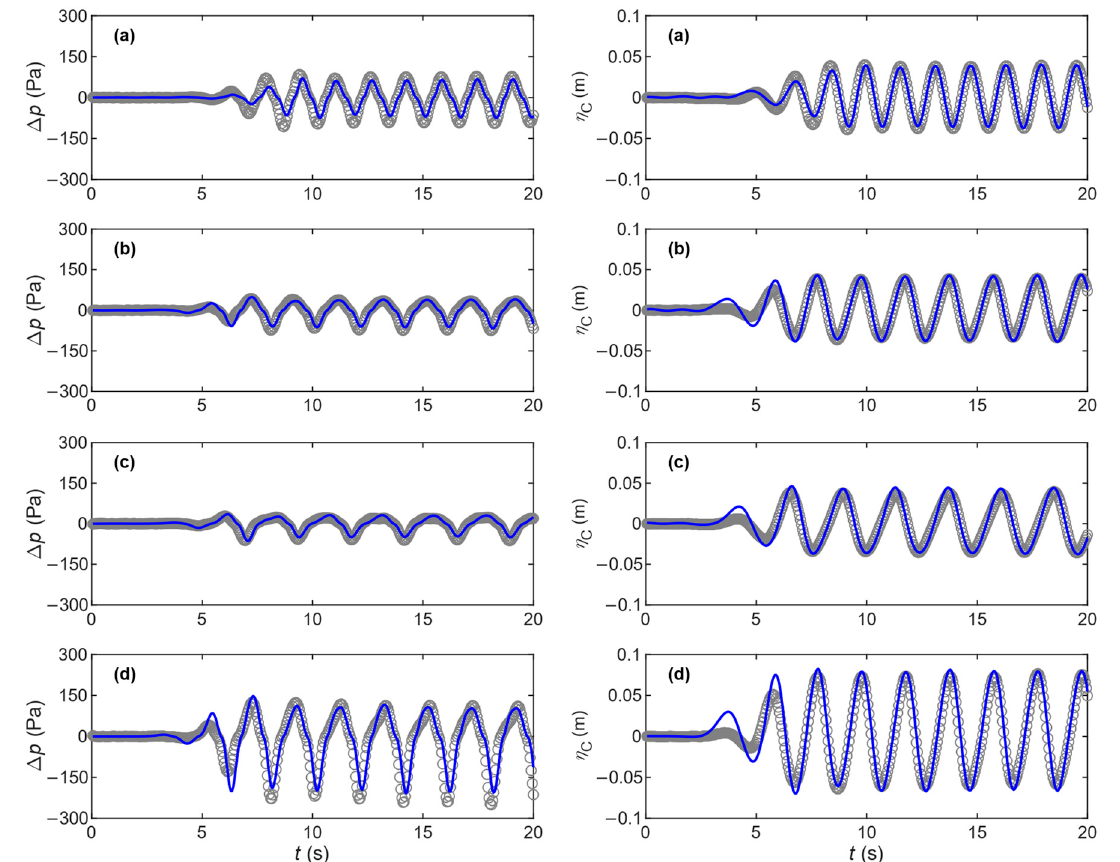
Figure 7. Pressure drop (left-hand panels) and free surface elevation (right-hand panels) time series for four different wave conditions: ( a ) H = 0.04 m, T = 1.6 s; ( b ) H = 0.04 m, T = 2.0 s; ( c ) H = 0.04 m, T = 2.4 s; ( d ) H = 0.08 m, T = 2.0 s ( ○ laboratory experiment, —numerical model).